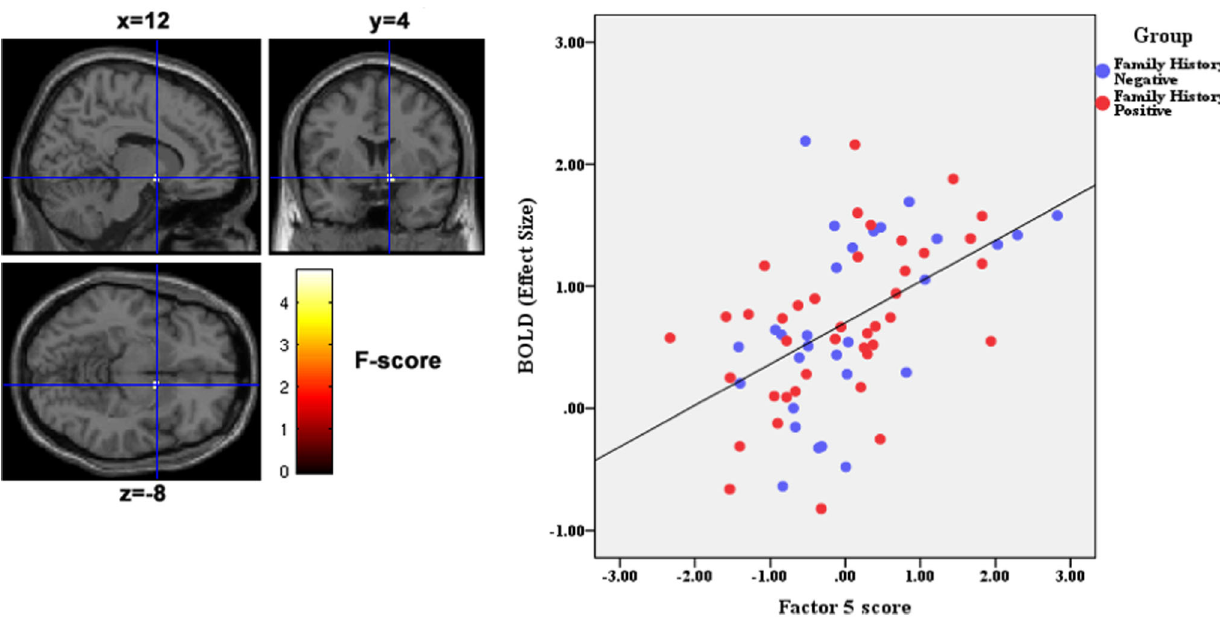
Figure 4. Correlation of Impulsivity-related Factor 5 (Behavorial Risk-Taking) scores with neural activation under the reward- punishment contrast across all subjects. A . Threshold was set at p , 0.05 FWE for voxels within the reward network mask. Statistical parametric F-maps (sagittal, coronal and axial) of the Reward-Punishment contrast for multiple regression against Factor 5 - ‘‘Behavioral Risk-Taking’’. Crosshairs overlaid on brain slices are at the voxel of peak correlation (MNI coordinates: x,y,z=12,4,–8). Bottom panel depicts individual factor scores vs. individual peak cluster activation at this voxel. B . Linear regression plot at the voxel of peak correlation between reward-punishment BOLD activity in the right ventral caudate and Factor-5 score for each subject.